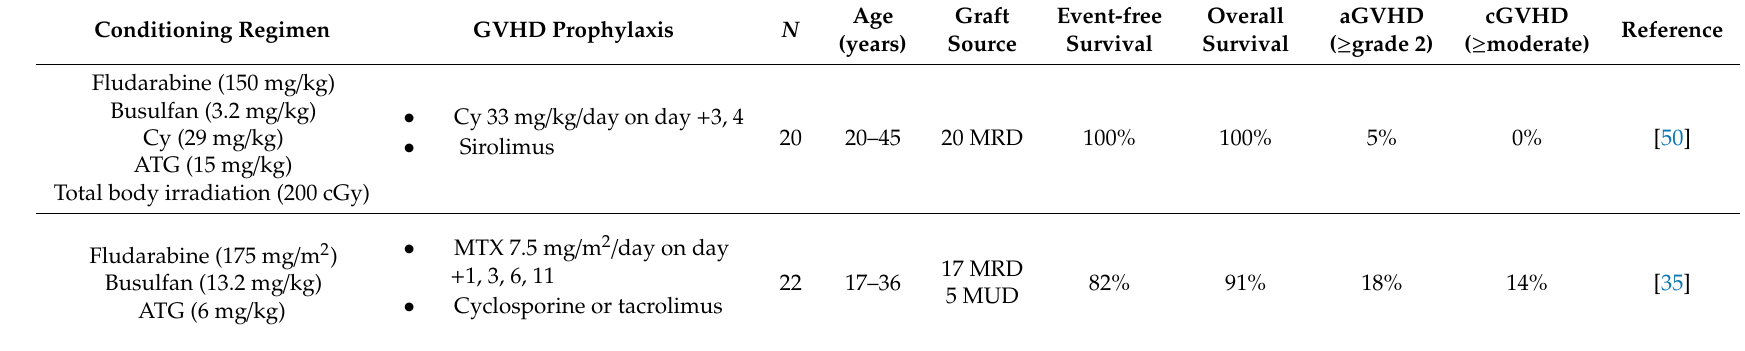
Table 2. Reduced-intensity conditioning regimens in adults with SCD.